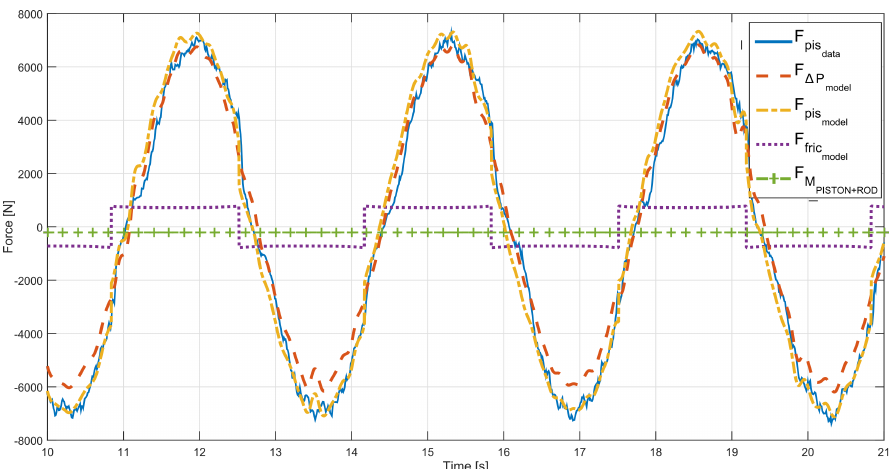
Figure 16. Contribution of the different forces in the hydraulic cylinder compared to the piston force measured in the test rig with the variable-pressure configuration.